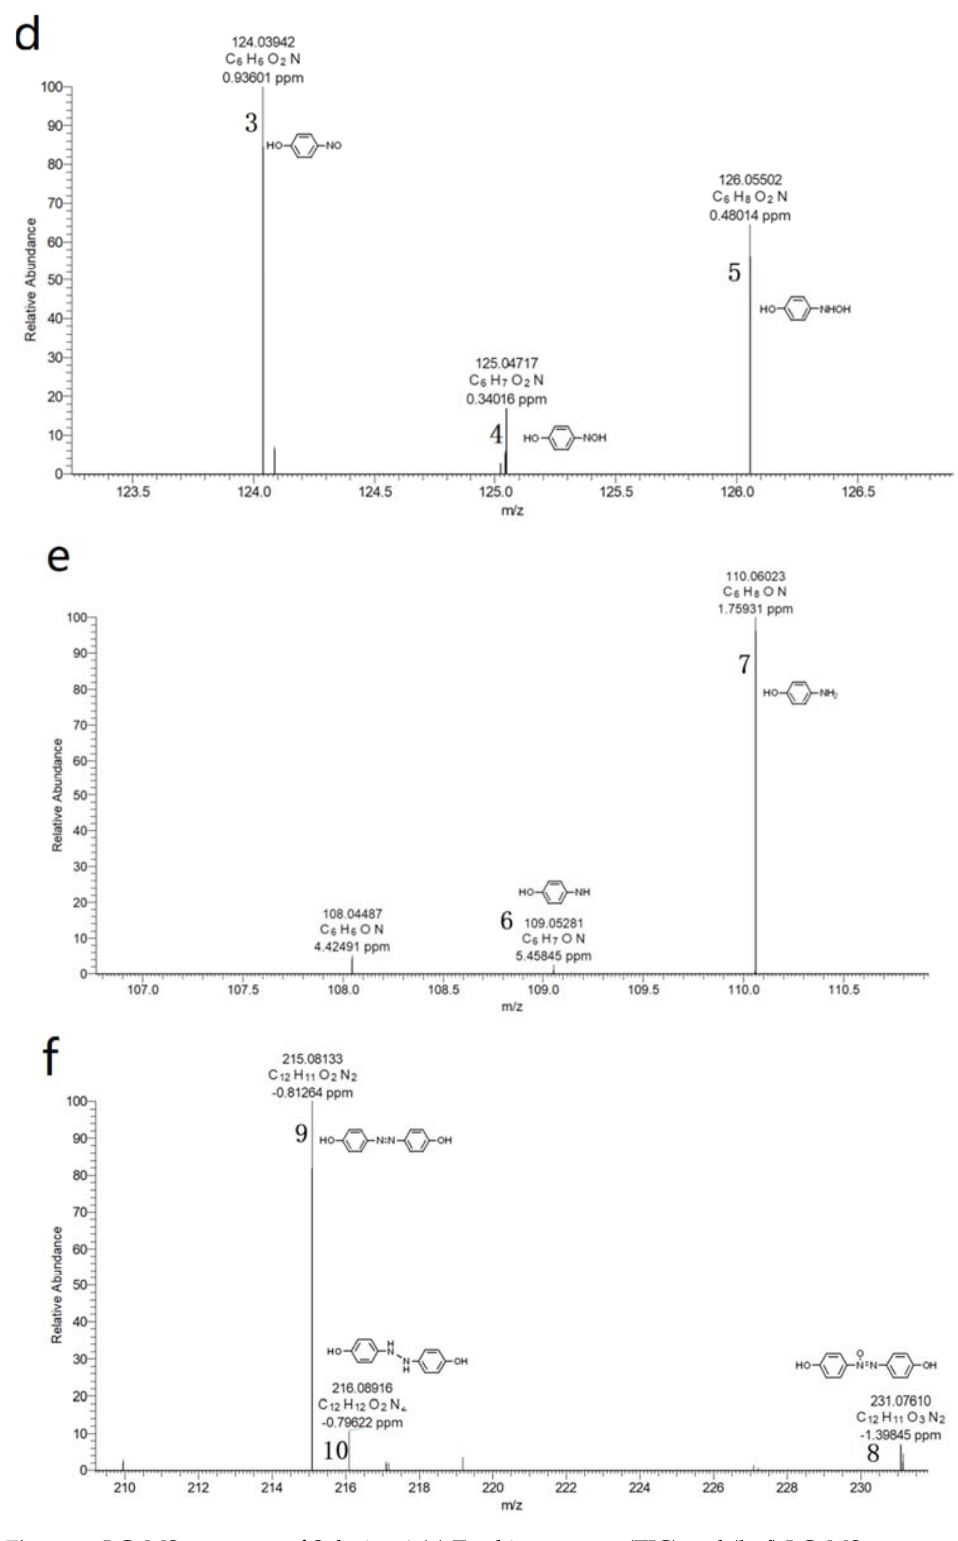
Figure 2. LC–MS spectrum of Solution 1 ( a ) Total ion current (TIC) and ( b – f ) LC–MS spectrum of each species monitored online at time node of 2 min.